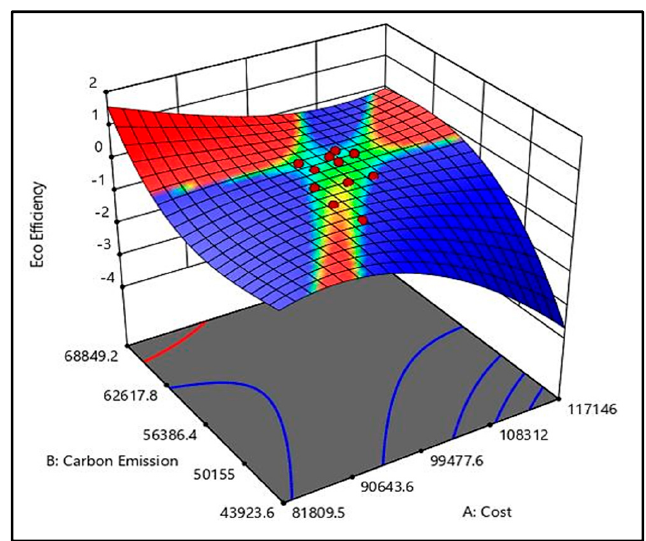
Figure 13. Response surface graph of fly ash based concrete used for double story houses.